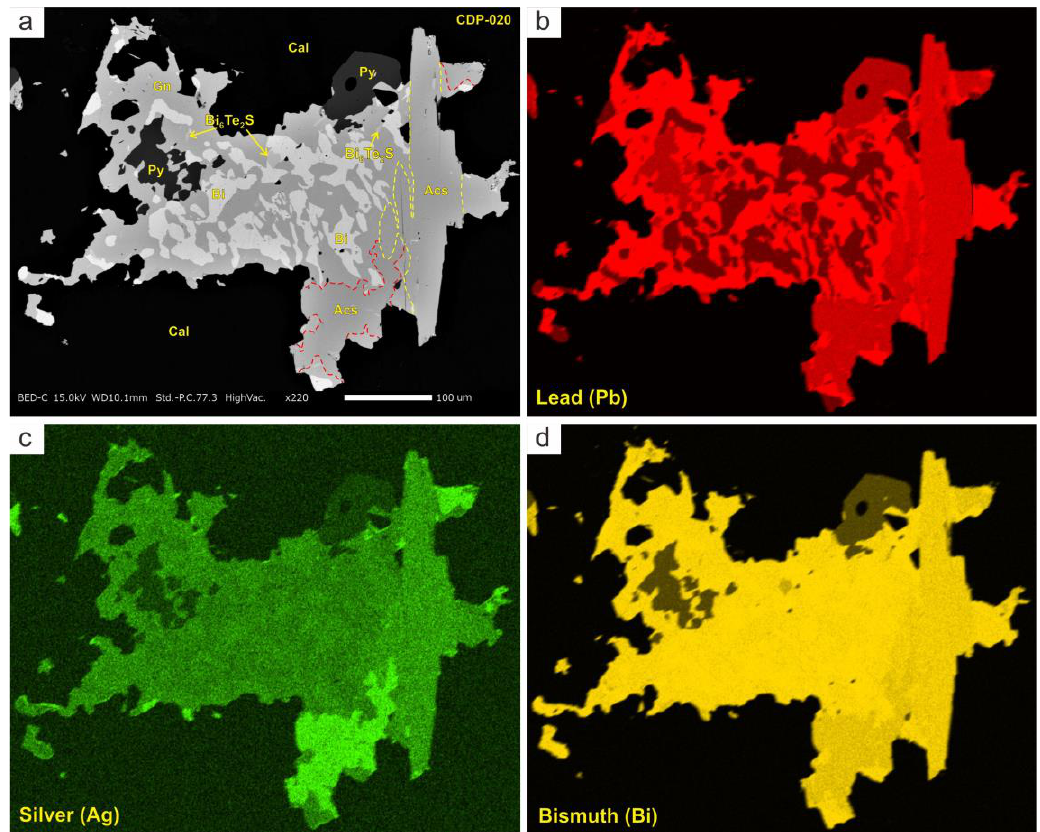
Figure 7. Representative image of backscattered electron ( a ) and elemental mapping ( b – d ) of com- plex Bi-Te-Ag-S bearing minerals. Abbreviation: Gn: galena; Py: pyrite; Cal: calcite; Bi: native bismuth; Acs: Ag-rich cossalite.